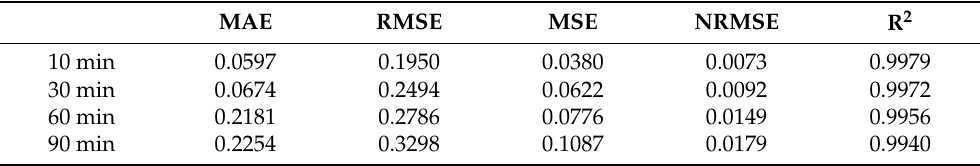
Table 5. Comparison of LightGBM–CGWO–SVR prediction accuracy at time steps of 10, 30, 60, and 90 min for humidity. MAE RMSE MSE NRMSE R 2 10 min 0.0597 0.1950